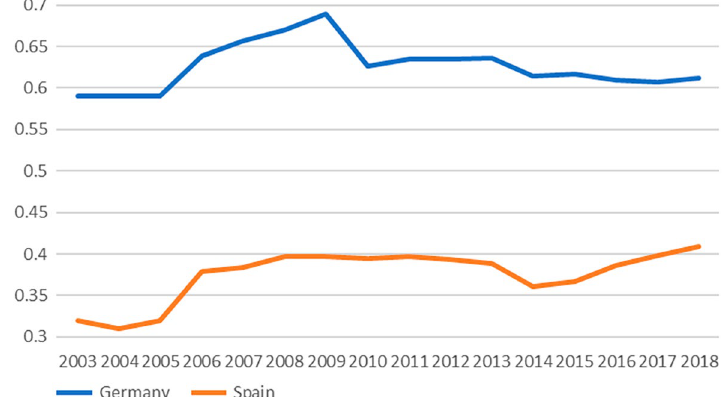
Figure 4. Summary innovation indexes of Germany and Spain through the